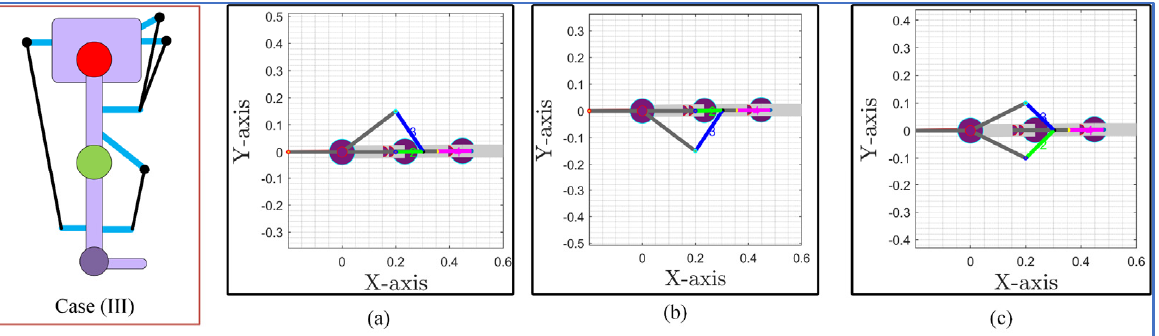
Figure 10. Case (III) and its sagittal and transverse plane view for different routings: ( a ) the 1 cable bi-planar routing (medial side), ( b ) the 1 cable bi-planar routing (lateral side), and ( c ) the 2 cables bi-planar (medial and lateral) routing.